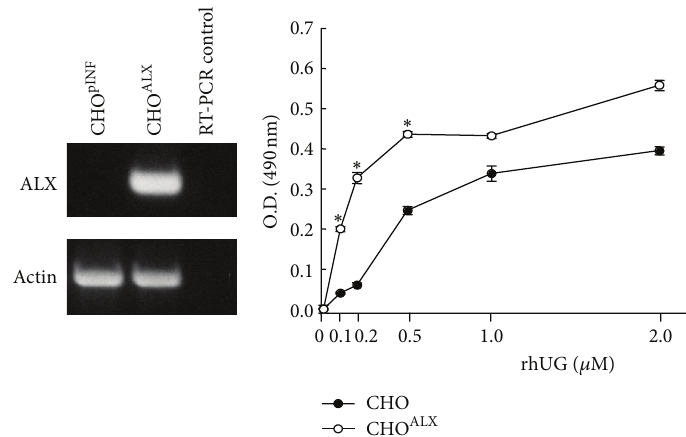
Figure 1: Exogenous hrUG binding by CHO cells expressing ALX shown by modified enzyme immunoassay. CHO cells expressing either the empty vector pcDNA3 vector ( CHO pINF ) or containing the full ALX open reading frame ( CHO ALX ) were exposed to increasing hrUG concentrations. The asterix notation indicates data points with a 𝑃 value of < 0.02 when comparing CHO ALX to CHO pINF data series. Results are plotted as a mean ± SD of quadruplicate determinations performed in three separate experiments. Reverse transcription-PCR was used to monitor the ALX mRNA expression in CHO cells stably transfected with ALX cDNA (inset). Control represents no template added to reaction. ALX is lipoxin A 4 receptor or FPR2/ALX. The result is from a representative gel of two